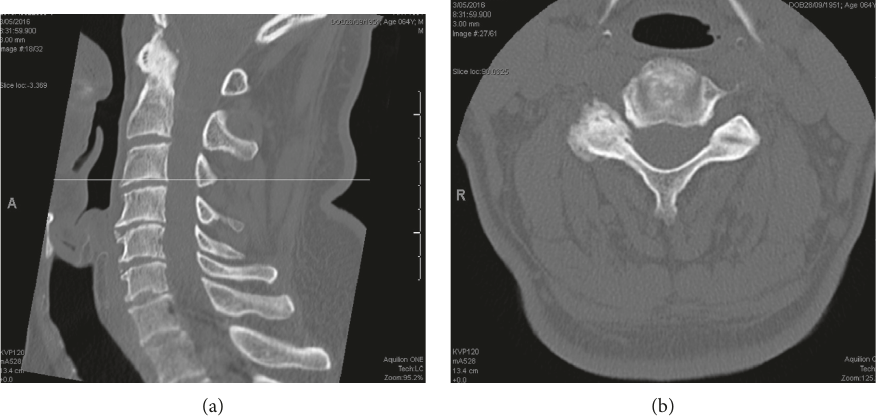
Figure 4: Preoperative CTscan of the cervical spine with sagittal slice and corresponding axial slice at the C3/4 level illustrating right-sided foraminal